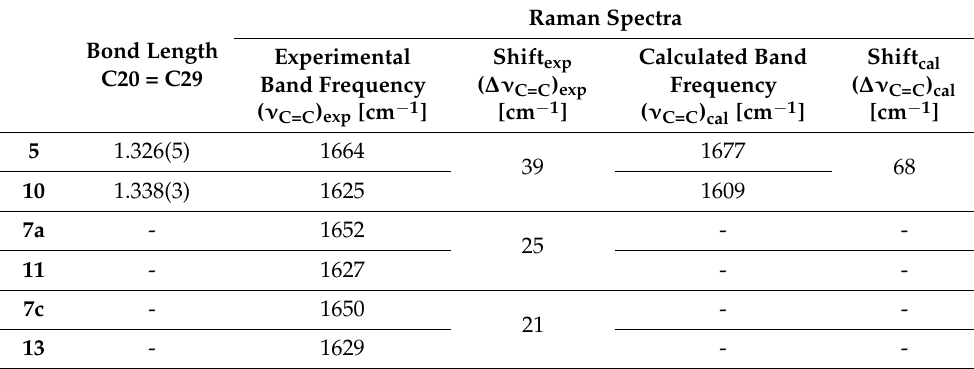
Table 2. Bond length and selected group Raman frequencies for the double bond C20–C29 experi- mental and calculated. Band shift ( ∆ ν C=C ) was calculated as a difference between band frequencies for following sets of compounds: 5 – 10 , 7a – 11 , and 7c – 13 .